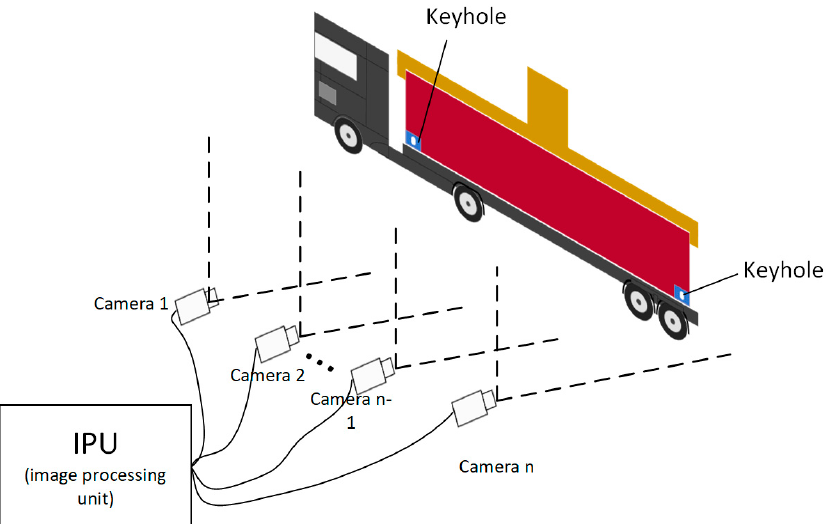
Figure 1. Hardware installation diagram.